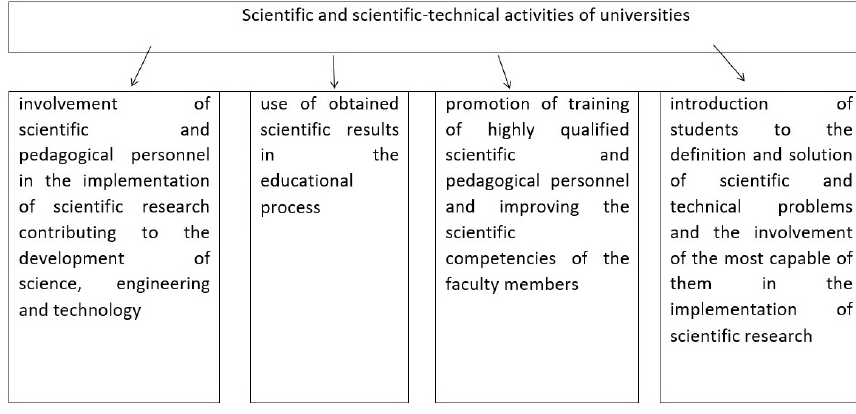
Fig. 1. Features of scientific and scientific-technical activities of